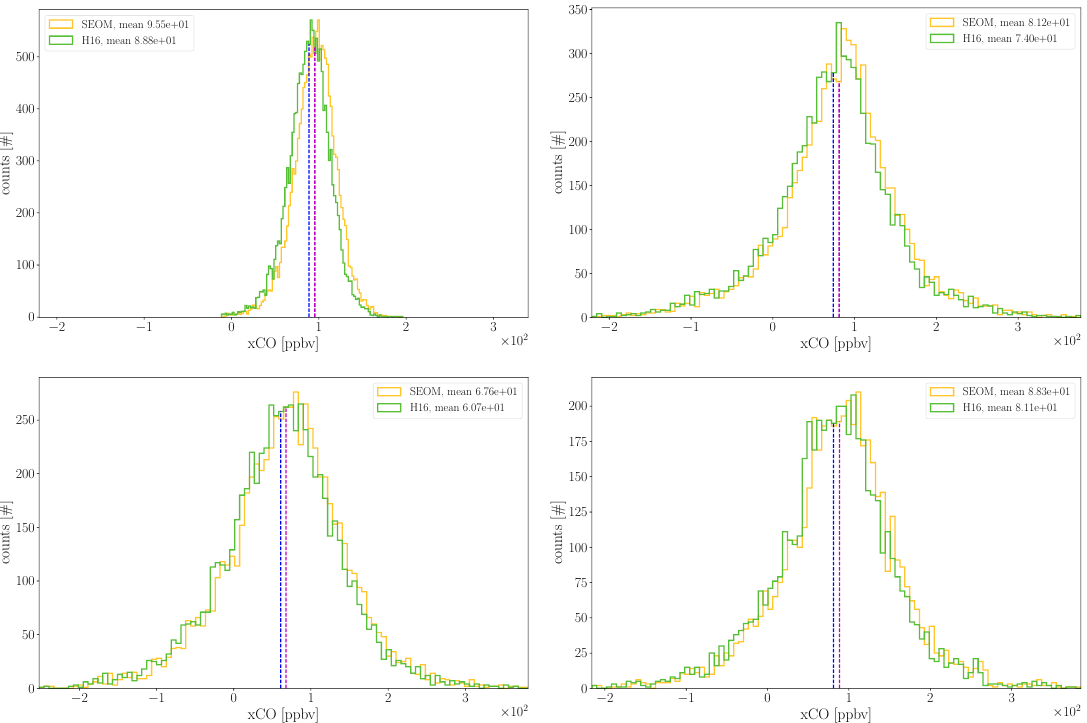
Figure 6. The distribution of xCO in the four analyzed regions Sahara (top-left), Siberia (top-right), Amazonia (lower-left) and CaPaAl for the April–June 2004 period. Please note that the retrieved mole fractions in the Sahara span a significant smaller